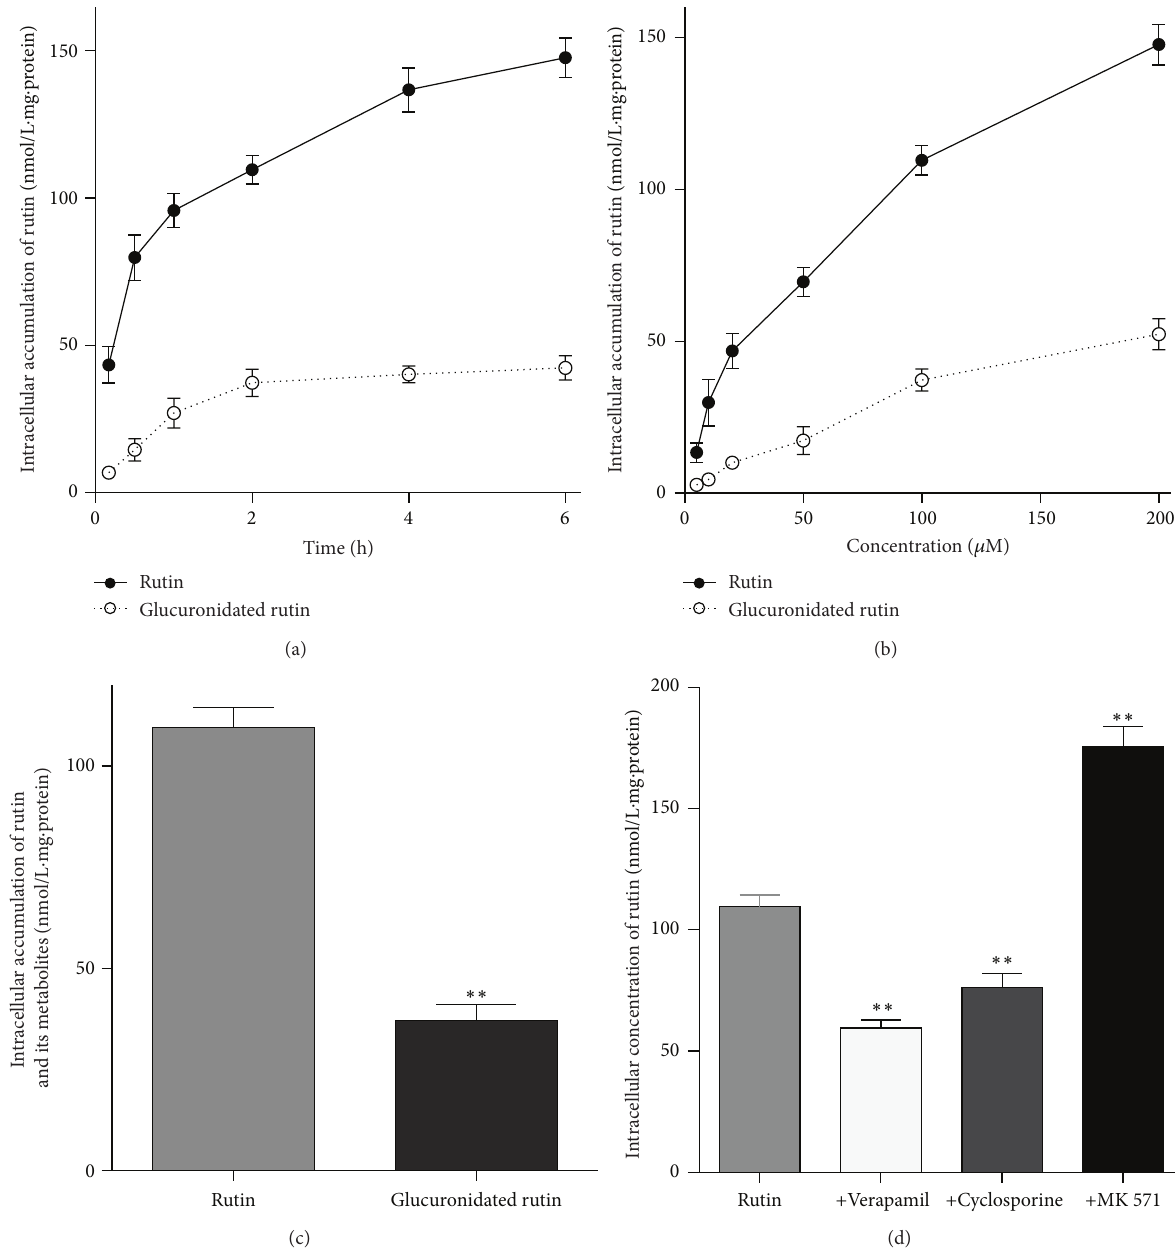
Figure 3: Absorption of rutin in Caco-2 Cells. (a) Time-dependent intracellular accumulation of rutin and its metabolites at 37 ∘ C from 10min to 6h. (b) Dose-dependent absorption of rutin and its metabolites at 37 ∘ C from 5 to 200 𝜇 M. (c) Intracellular accumulation of rutin and its metabolites after incubation with 100 𝜇 M rutin for 2h. (d) Intracellular accumulation of rutin in the presence of different inhibitors (10 𝜇 M verapamil, 20 𝜇 M cyclosporine, 20 𝜇 M MK 571, respectively). Each value is the mean ± the SD of seven determinations. Statistical significance: ∗∗ 𝑃 < 0.01 ; ∗ 𝑃 < 0.05